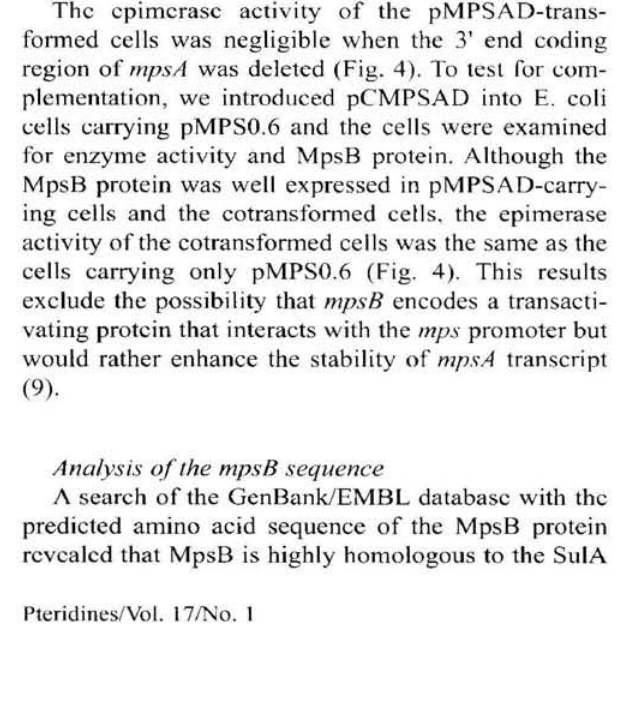
Figure 3. SDS-PAGE of E. coli DH5a cells carrying mps deletion plasmids. The HjNTP epimerase bands (14kDa) are indicated by the arrow. Lane 1, pBluescript; Lane 2, pMPS; Lane 3, pMPSLS; Lane 4, pMPSL3; Lane 5, pMPSLO; Lane 6, pMPSO.6. galcagg-3' and 5'-ctgggatccgggagttaactggcgga-3'. The resulting fragment was digested and cloned into pET15b {Barnm-NdeV).